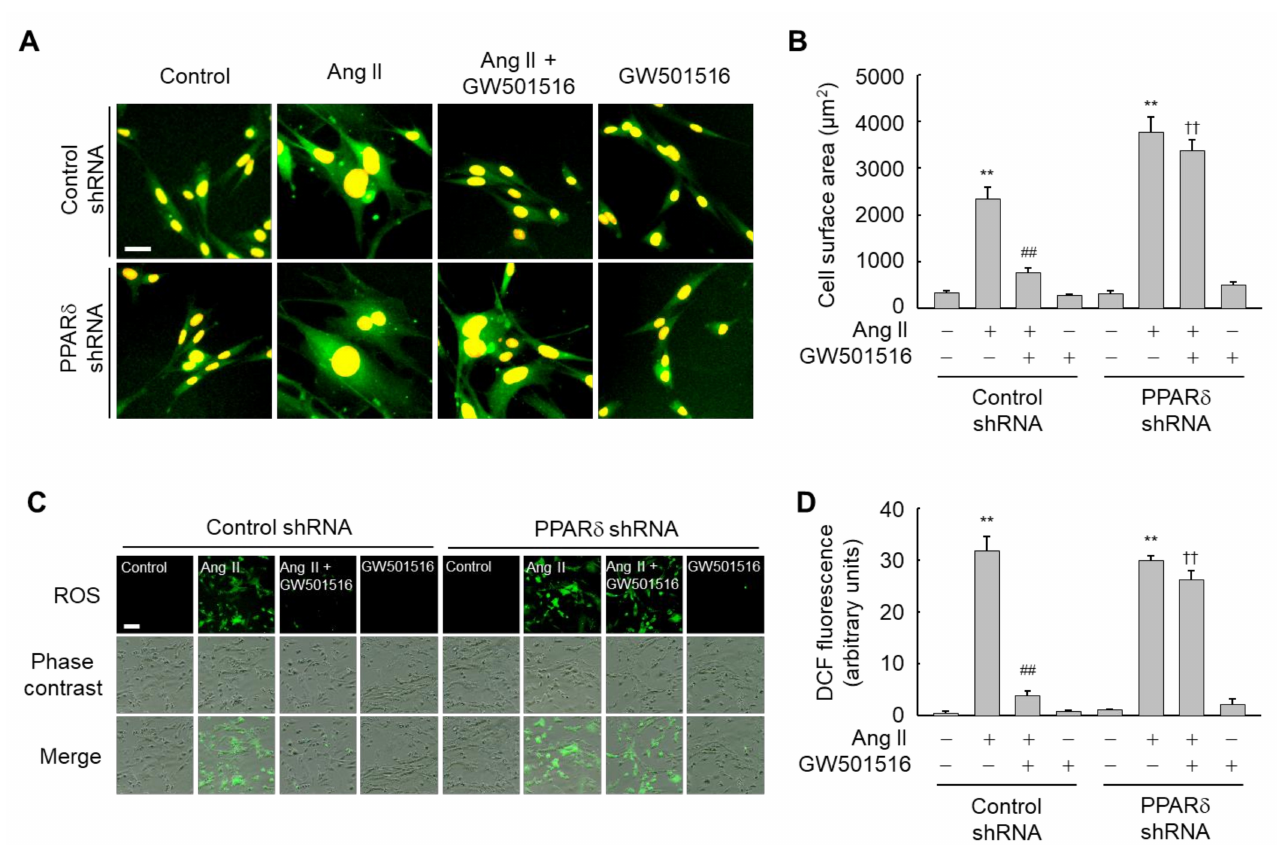
Figure 2. RNAi-mediated knockdown of PPAR δ abolishes the effects of GW501516 on Ang II-induced hypertrophy and ROS production in H9c2 cardiomyocytes. Cells stably expressing PPAR δ shRNA or scrambled control shRNA were pretreated with 100 nM GW501516 or vehicle (DMSO) for 12 h, and then exposed to 100 nM Ang II. Following incubation for 24 h (for hypertrophy detection) or 2 h (for ROS detection), immunofluorescence assays were performed using α -actinin antibody ( A ), and cell surface area was quantified using an image analyzer and then plotted ( B ). Intracellular ROS accumulation was analyzed by fluorescence microscopy using 10 µ M CM-H2DCF-DA ( C ), and the fluorescence intensity was quantified ( D ). Representative images from four independent experiments are shown. Bars = 100 µ m. Results are expressed as mean ± standard error (SE) ( n = 4; ** p < 0.01 compared with the untreated group; ## p < 0.01 compared with the Ang II-treated group; †† p < 0.01 compared with the Ang II plus GW501516-treated control shRNA